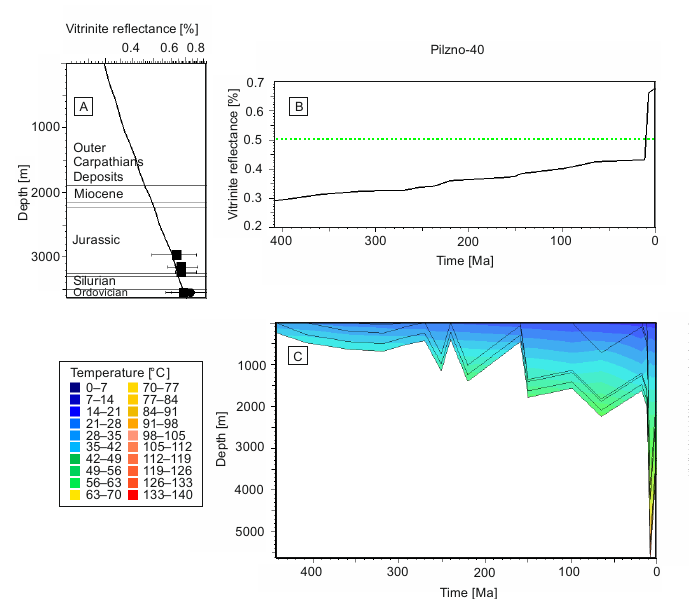
Figure 5. Burial and thermal history model (no. 1) for the Pilzno-40 well assuming Late Miocene overthrusting of the Outer Carpathians: ( A ) calibration of the model by comparison between measured VR values and calculated VR curve; ( B ) VR evolution with time showing a rapid increase due to the Carpathian overthrust. The green dash line is the VR value equals 0.5% that represents border between immature and mature kerogen; ( C ) burial history curves with temperature overlay. Note the fast temperature increase in the late Miocene.